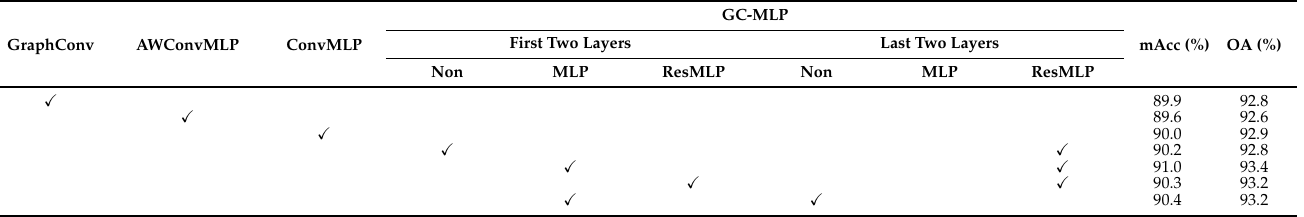
Table 4. Comparison of classification results of different schemes based on ModelNet40 dataset.